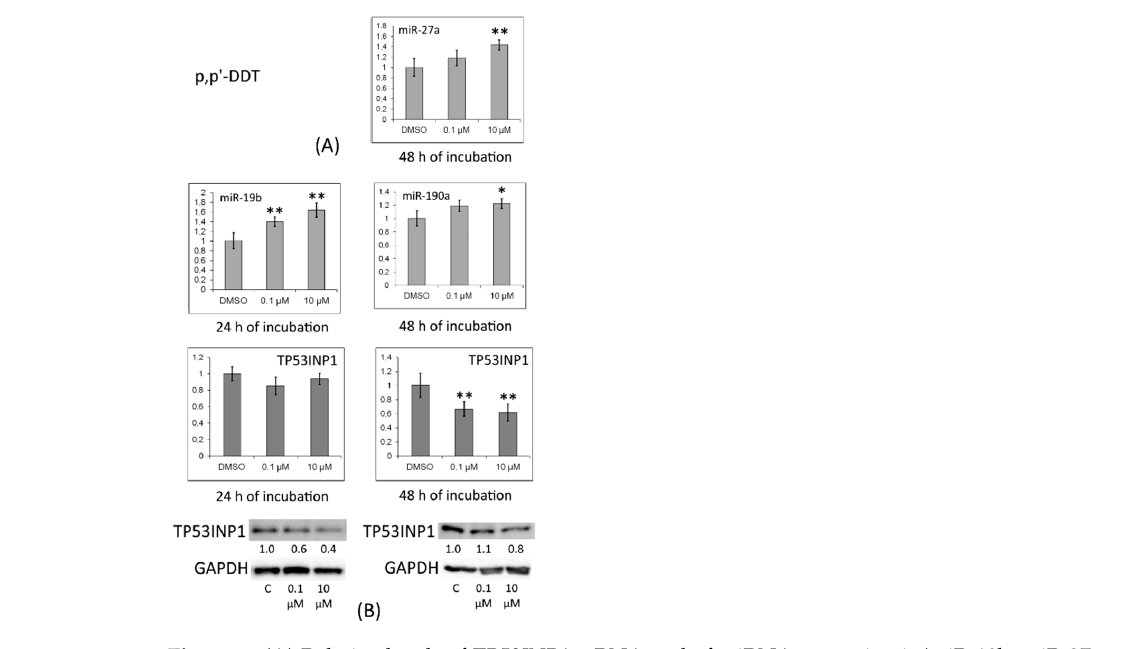
Figure 7. ( A ) Relative level of miR-190a in MCF-7 cells exposed to o,p ′ -DDT for 48 h. The Y-axis shows the ratio of the miRNA amount in the cells treated with a DDT isomer to the miRNA amount